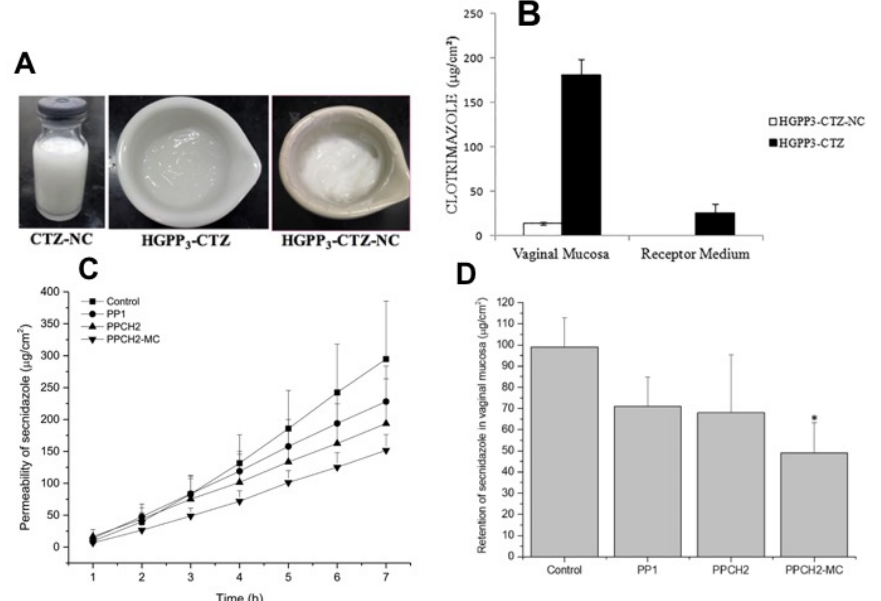
Figure 8. Hydrogel formulations containing clotrimazole nanocapsules ( A ). The results of ex vivo permeation and retention evaluations in vaginal mucosa of hydrogel formulations containing clotrimazole ( B ) [171]. Reprinted with permission from ref. [171]. Copyright 2017 Elsevier Inc. The results of ex vivo permeation ( C ) and retention evaluations in vaginal mucosa ( D ) of secnidazole loaded hydrogels [217]. * p < 0.05 compared with Control group. Reprinted with permission from ref. [217]. Copyright 2021 Elsevier Inc.